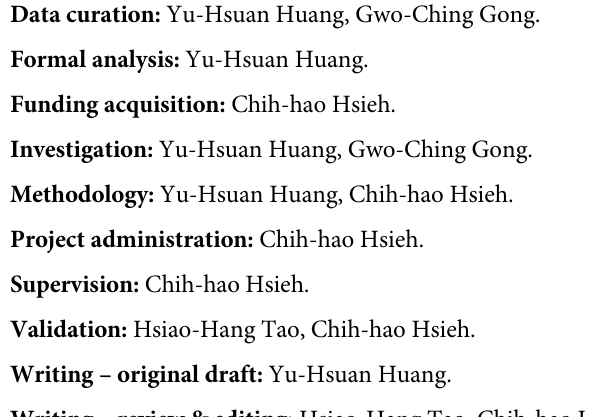
S1 Table. Densities of zooplankton, larval fish, and environmental variables of each cruise- station. S2 Table. Size composition of small-size zooplankton of each cruise-station. S3 Table. The results of linear mixed effect models linking larval density with zooplankton density and environmental factors. S1 Fig. Relationships of chlorophyll-a concentration versus log-transformed density of small-size zooplankton, mesozooplankton, and larval